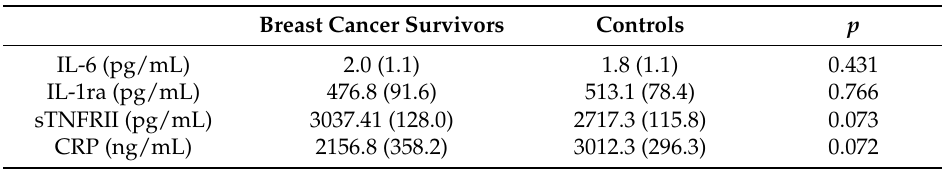
Table 5. Inflammatory